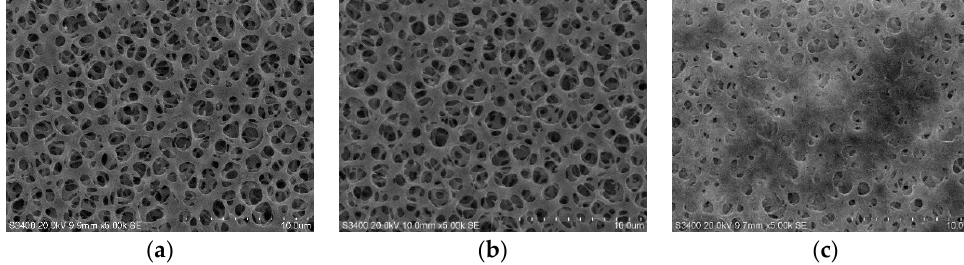
Figure 6. SEM images of membrane surface after performed in Franz cell apparatus; blank ( a ) tea seed oil ( b ) and SEOF ( c ).